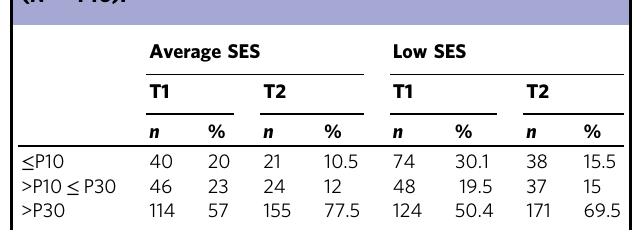
Table 7 Percentage distribution according to the SES ( N =